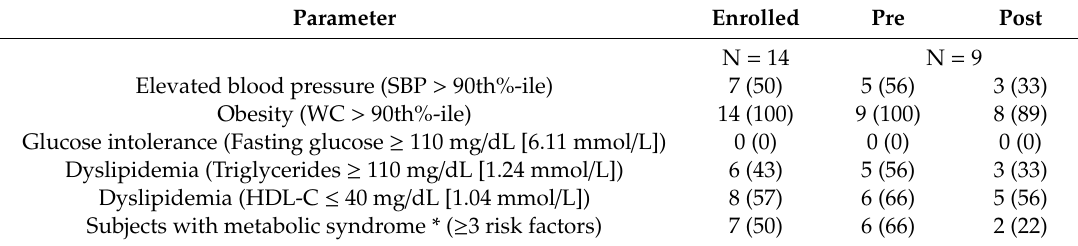
Table 2. Prevalence of metabolic syndrome pre- and